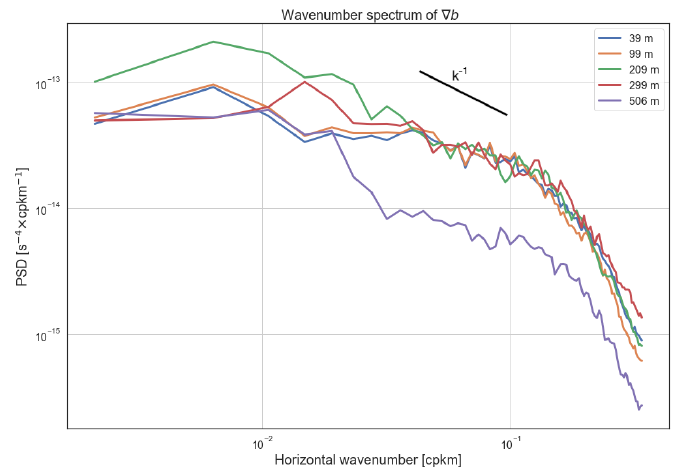
Figure 3. Wavenumber spectrum of ∇ b -amplitude at different depths for a randomly selected snapshot taken on 27 October 2011 00:00:00 UTC.